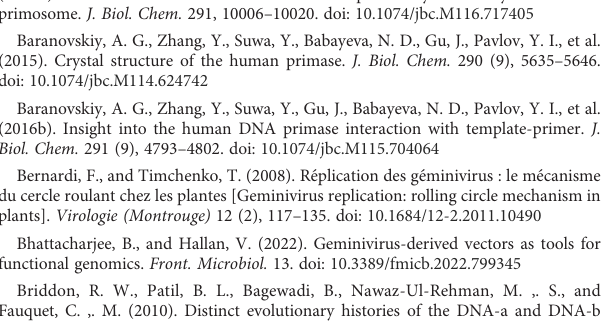
SUPPLEMENTARY TABLE 1 Primers used for